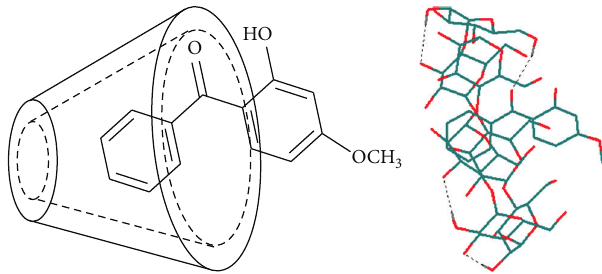
Figure 8: Hypothetical structure of Oxy: 𝛽 -CD inclusion